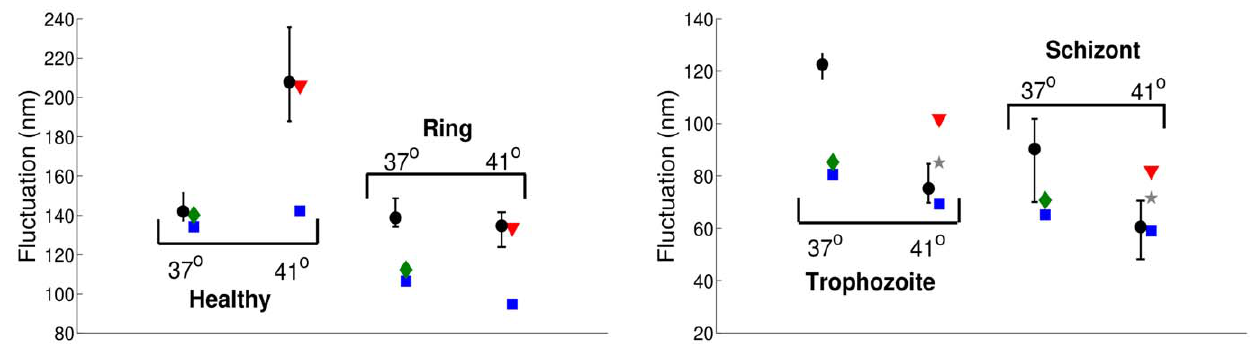
Figure 7. Pf-RBC full-width half-maximum (FWHM) values of fluctuation distributions for different stages of the parasite development at the physiological T ~ 37 o C and the febrile T ~ 41 o C temperatures. Black circles are the median values of FWHM in experiments [4], while error bars correspond to standard deviation. Other symbols are the FWHM values in simulations. Blue squares assume the bending rigidity k c ~ 2 : 4 | 10 { 19 J , green diamonds 4 k c = 5 , red triangles k c = 4 , and gray stars k c = 2 . (The statistical error in all simulations is negligible.) The corresponding shear moduli are outlined in Table 2. The membrane viscosity in all cases is assumed to be 0 : 022 Pa : s .